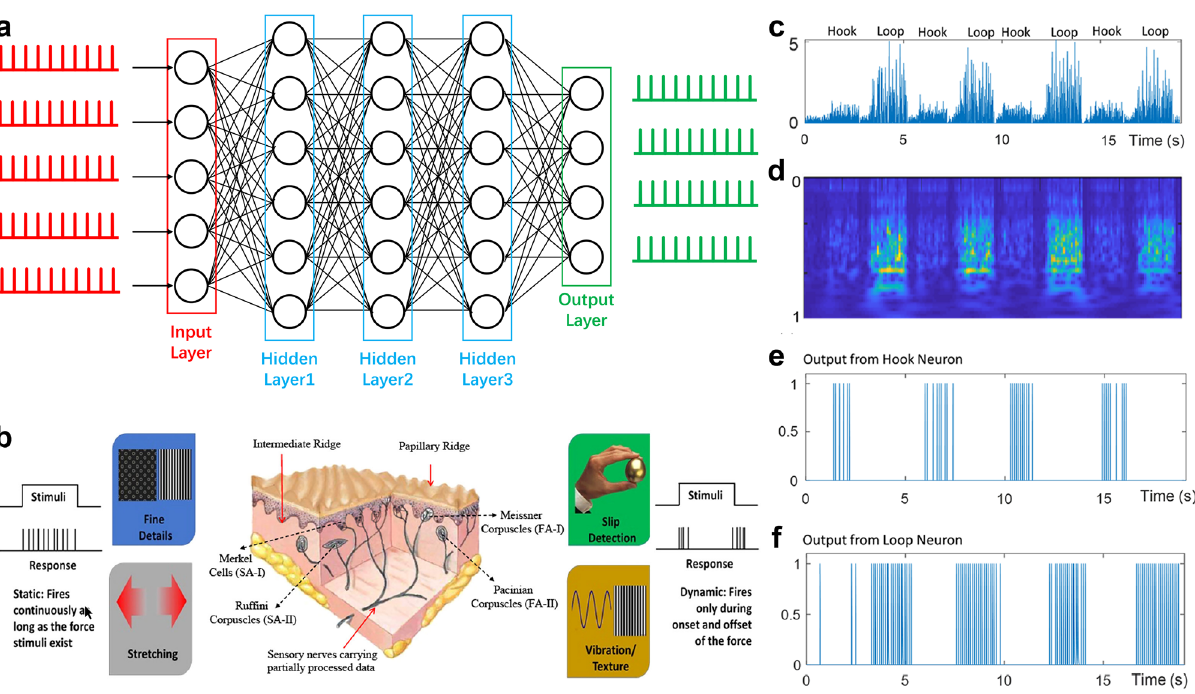
Fig. 30 Signals detected by the soft system and processed by SNN. a Schematic diagram of SNN. b Mechanoreceptors in the human skin which enable the tactile sensation. SA mechanoreceptors respond with continuous spikes during the static stimuli and the FA mechanoreceptors respond with spikes during the transition or the dynamic part of the stimuli. c A typical recorded signal from the dynamic scan when the sensor touching different texture (Hook and Loop). d Gabor wavelet scalogram of different texture signals (Hook and Loop) corresponding to c . Output from the tempotron SNN classifier neuron corresponding to e Hook and f Loop. Reproduced with permission [345]. Copyright (2019), Wiley–